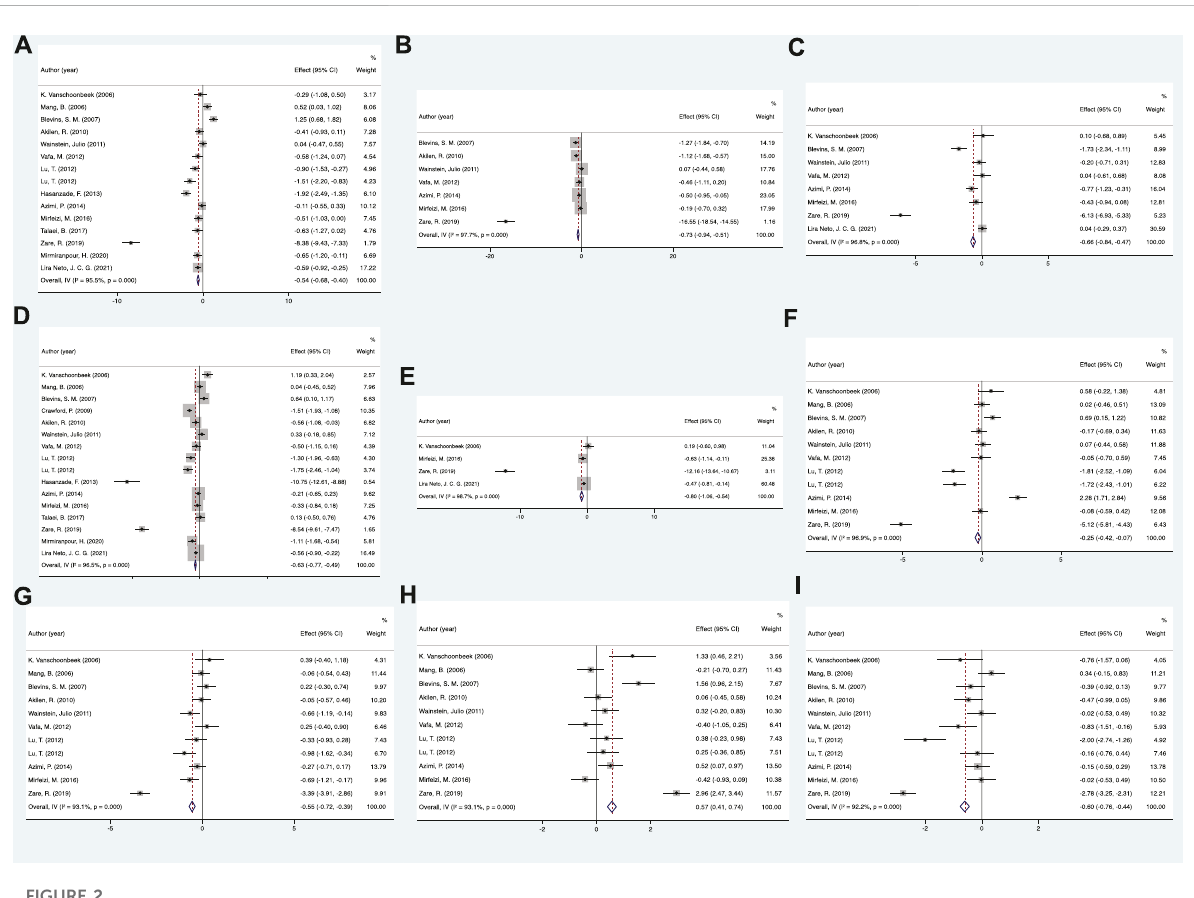
FIGURE 2 Mean difference in the changes in glycolipid metabolism indexes. (A) FPG, (B) BMI, (C) insulin, (D) HbA1c, (E) HOMI-IR, (F) TC, (G) LDL-c, (H) HDL-c, and (I) TG.FPG, fastingplasma glucose; BMI,body massindex;HbA1c,glycated hemoglobin A1c;HOMA-IR,homeostaticmodelassessment of insulin resistance; TC, total cholesterol; LDL-c, low-density lipoprotein cholesterol; HDL-c, high-density lipoprotein cholesterol; TG,